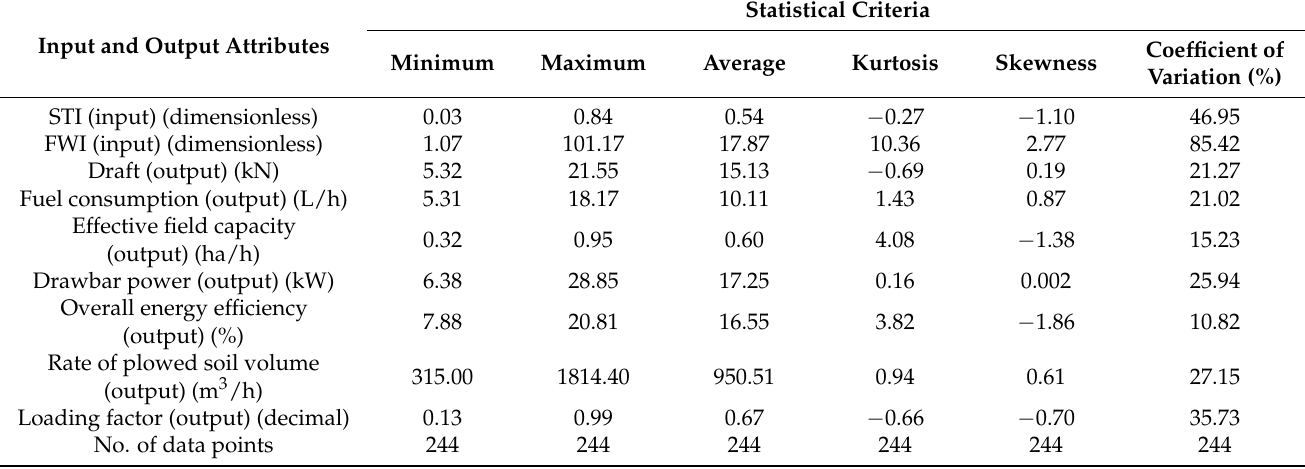
Table 3. Statistical criteria of the input variables and performance attributes (outputs) used in ANN and MLR